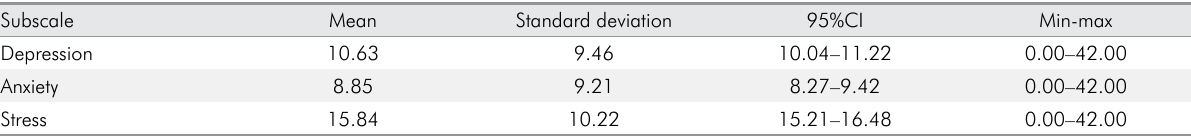
Table 3. Descriptive statistics of depression, anxiety and stress scores in Brazilian dentists during the COVID-19 pandemic.